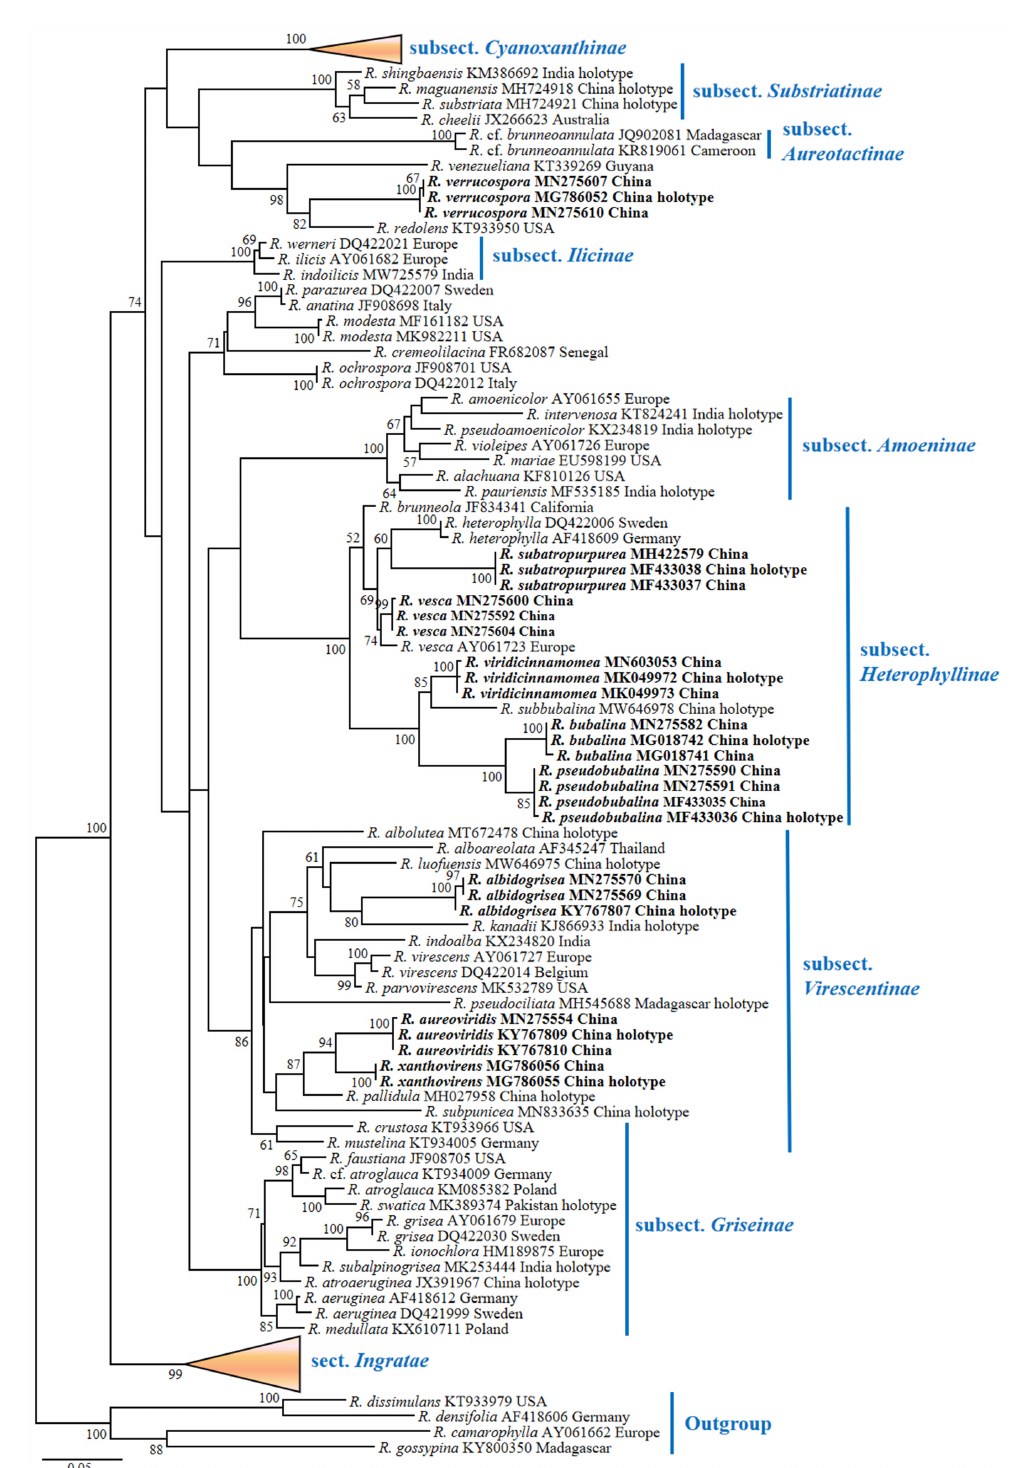
Fig. 1-1. Phylogram of Russula Pers. subgen. Heterophyllidiae Romagnesi, emend. Buyck & V.Hofst. generated using the maximum likelihood (ML) method based on rDNA ITS sequences performed by RAxML. The clades representing subsect. Cyanoxanthinae Singer and sect. Ingratae Quel. are compressed and separately displayed in Figs 1-2, 1-3. Bootstrap values higher than 50% are shown above or below the branches. Species collected from Dinghushan Biosphere Reserve are shown in